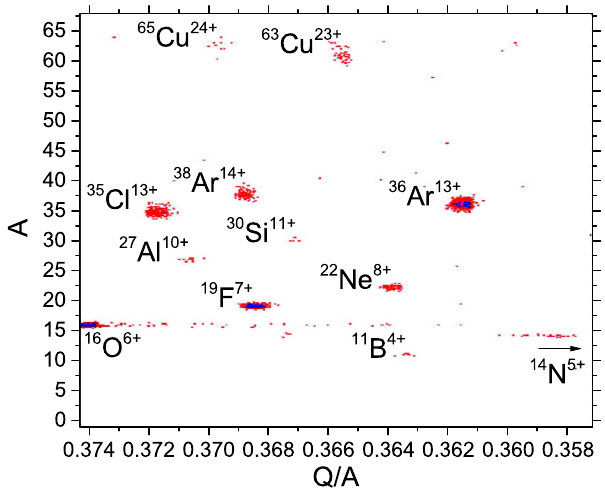
FIG. 13. Map of stable-isotope contaminants obtained by scanning the field strength of the Q=A separator ’ s magnet while reaccelerating beams through the ReA RFQ to 600 keV = u × A and measuring the energy of single ions with a silicon